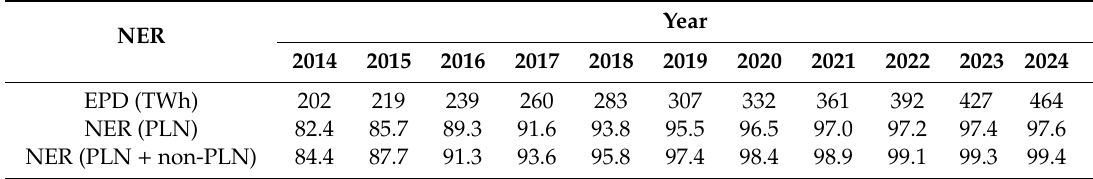
Table 1. Current and projected NERs from 2014 and 2024